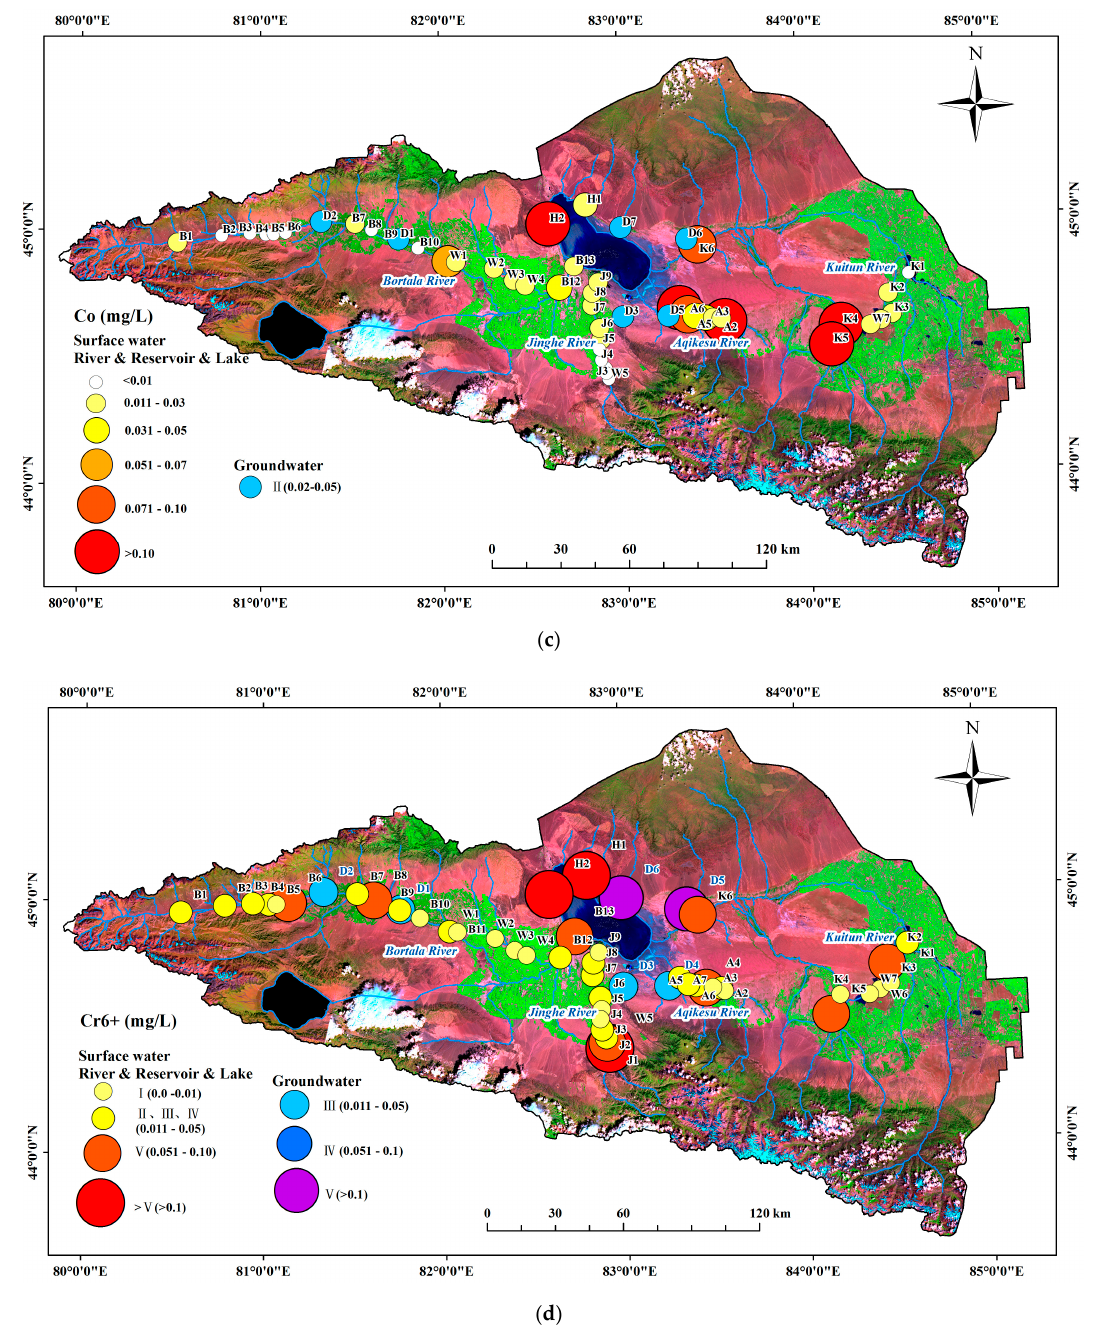
Figure 9. Spatial distribution of trace element concentrations (Cu ( a ), Zn ( b ), Co ( c ), and Cr 6+ ( d )) in ff erent water different water samples. di